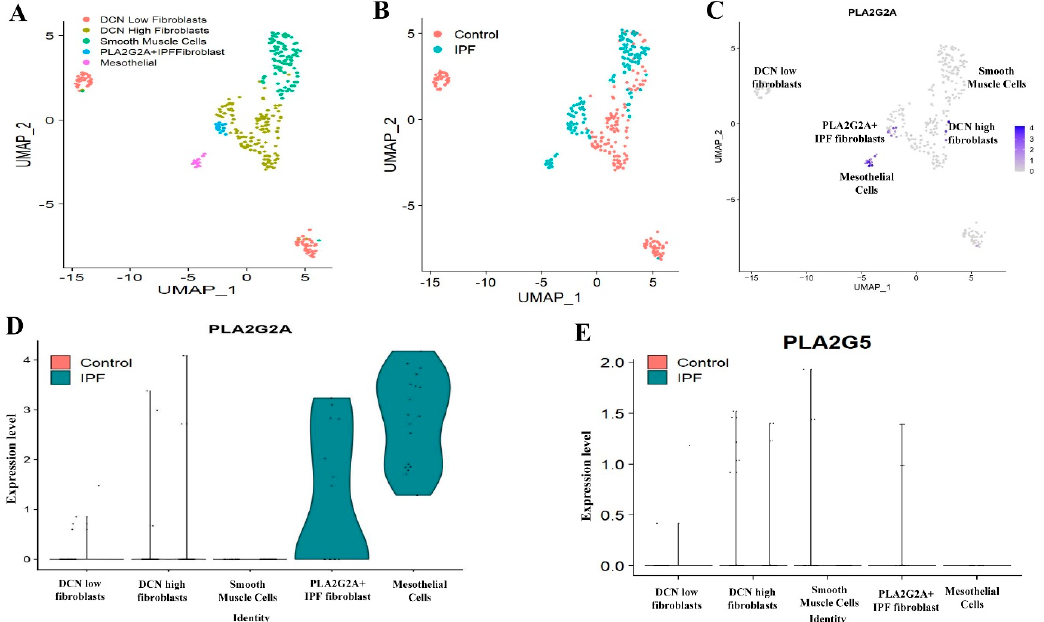
Figure 4. Analyzing expression of PLA2G2A and PLA2G5 in mesenchymal cells in data set C (GSE122960). ( A ) UMAP visualization of mesenchymal cells, various clusters displaying different types of mesenchymal cells. ( B ) UMAP plot showing cells, colored by their origin either from Control or IPF patients. ( C )Feature plot displaying expression of PLA2G2A. ( D ) Violin plot showing expression of PLA2G2A in various subclusters of mesenchymal cells. ( E ) Violin plot of expression of PLA2G5 in mesenchymal cells.